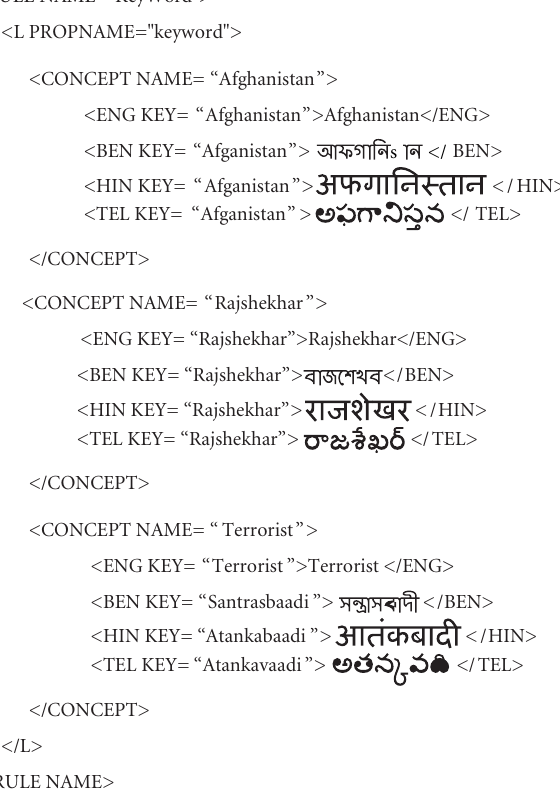
Figure 2: Keyword list